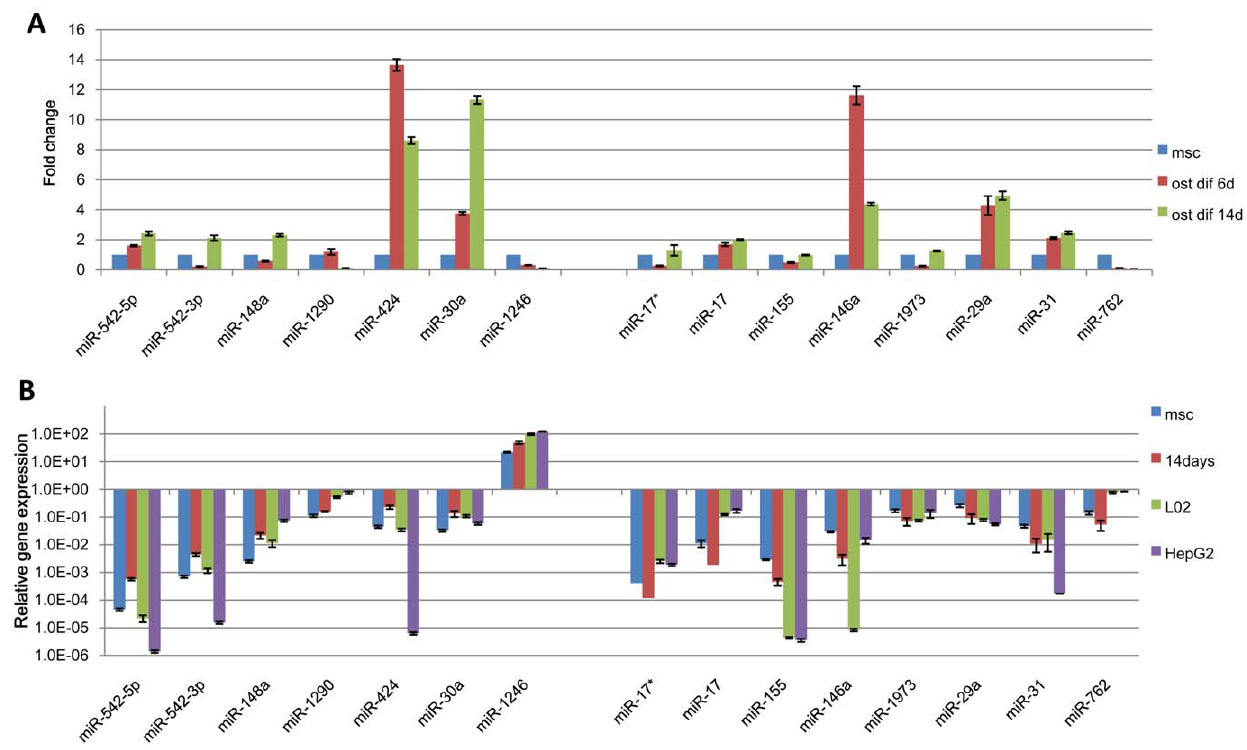
Figure 6. Expression of hepatic differentiated hUC-MSC microRNA profile in osteogenic differentiated hUC-MSC and hepatocyte and hepatocellular carcinoma cells. A: MicroRNA expression was analyzed by qRT-PCR at osteogenic differentiated day 6 and day 14 and normalized to U6B expression. Results are expressed relative to a value of 1 in the control hUC-MSCs. B: MicroRNA expression was analyzed by qRT- PCR in hepatocyte and hepatocellular carcinoma cells and normalized to U6B expression.